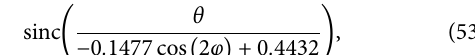
Frontiers in Signal Processing |